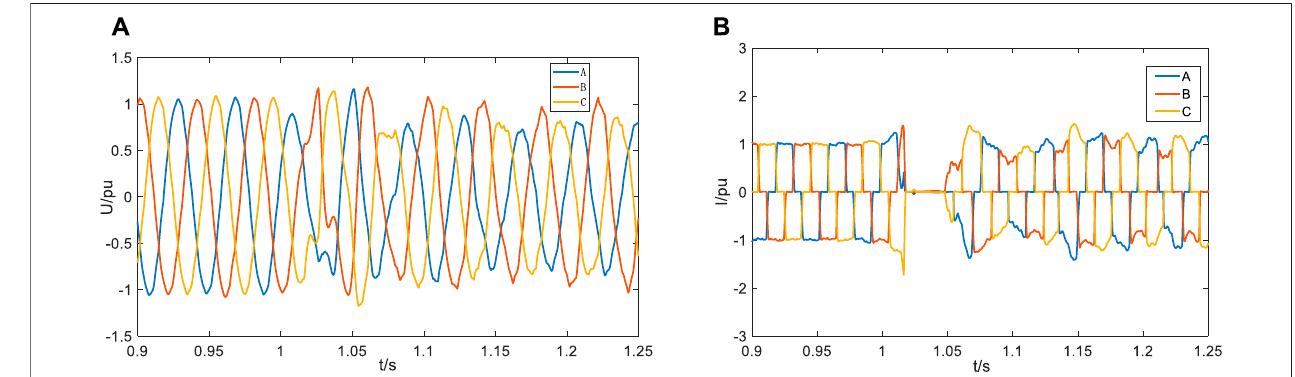
FIGURE 12 | Simulation waveform diagram after installing conventional STATCOM: (A) AC voltage on the inverter side and (B) inverter current of the converter valve.